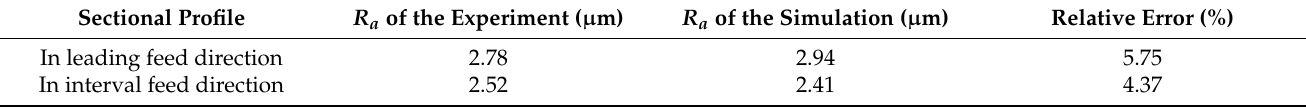
Table 3. R a of the experimental and simulated sectional profiles of the micro surface topography.